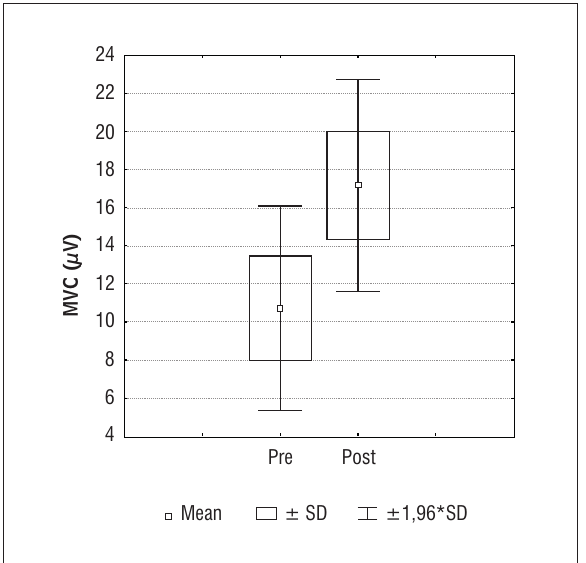
Figure 1 - Measurement of maximum voluntary contraction (MVC) by the electrical activity of the pelvic floor ( μ v = microvolt), before and after 16 sessions of endoanal electrostimulation (Student’s paired t-test, - 3.39; P = 0.008)